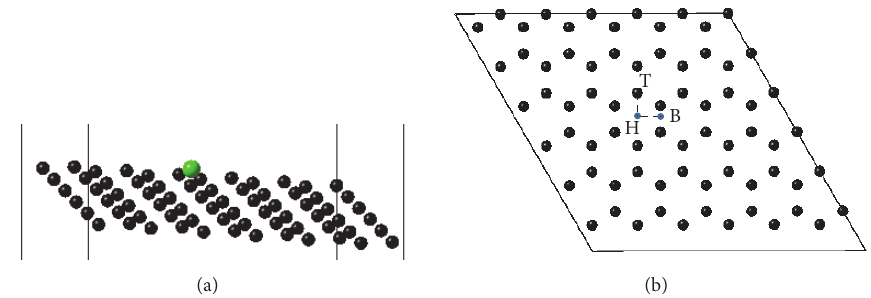
Figure 1: (a) The supersurface of Co on graphite. (b) The three adsorption sites on the graphite surface, where T, B, and H represent the Top, Bridge, and Hollow positions.